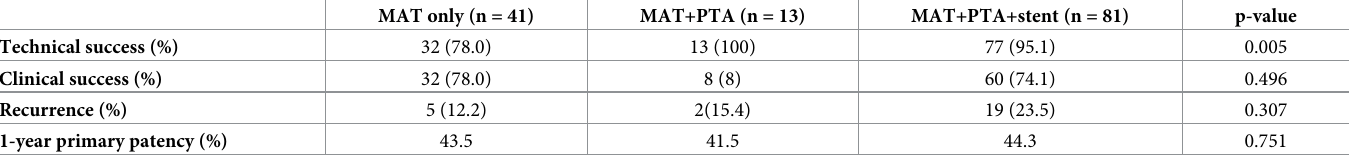
Table 3. Summary of outcomes based on